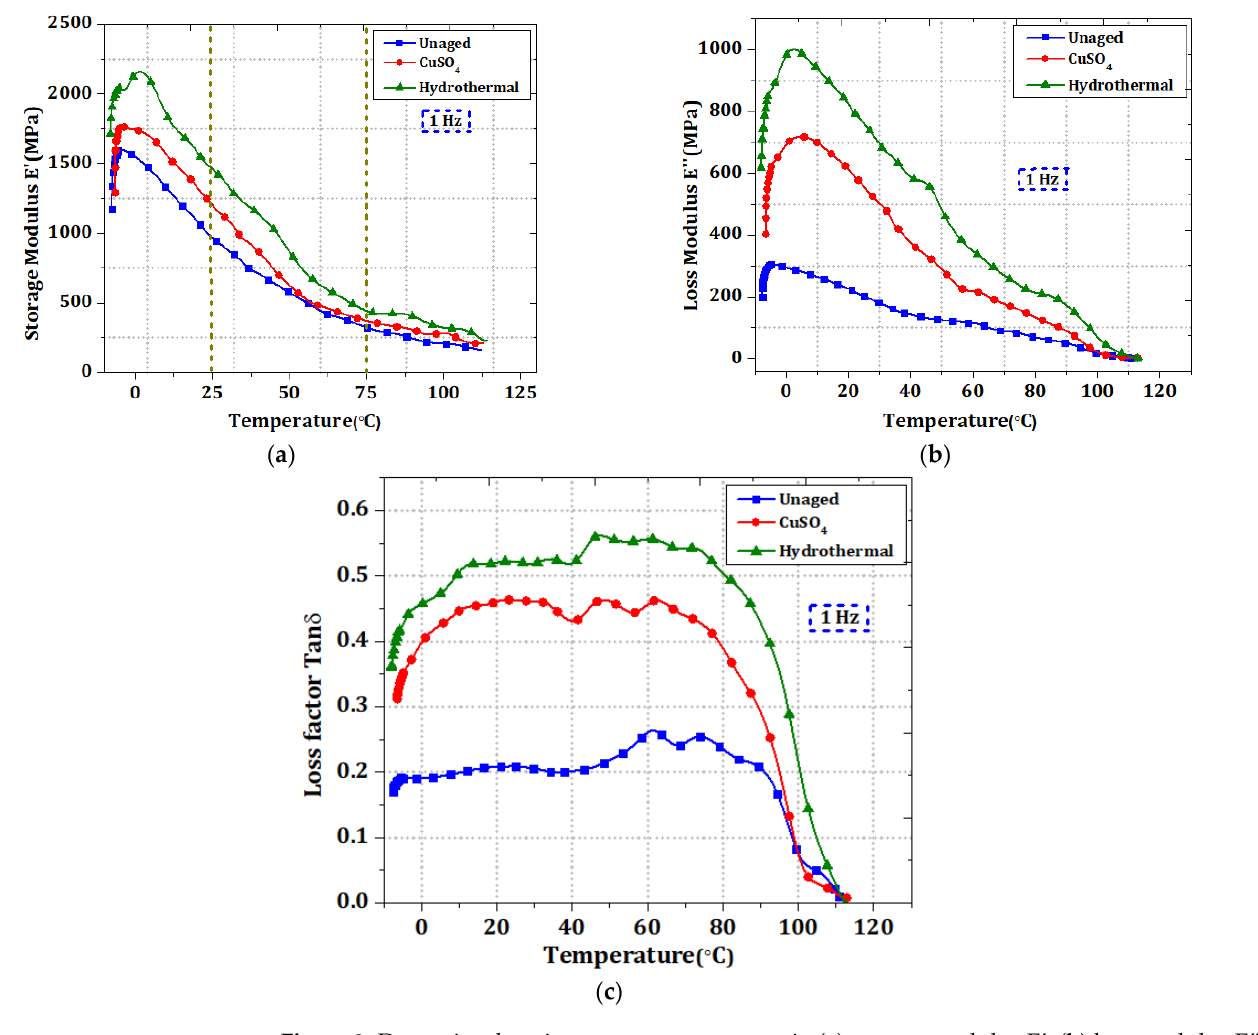
Figure 8. Dynamic relaxation temperature spectra in ( a ) storage modulus E’, ( b ) loss modulus E”, and ( c ) mechanical loss factor for unaged, CuSO 4 , and hydrothermally aged XLPE samples. Table 3. Mechanical loss factor and storage modulus of various XLPE samples.